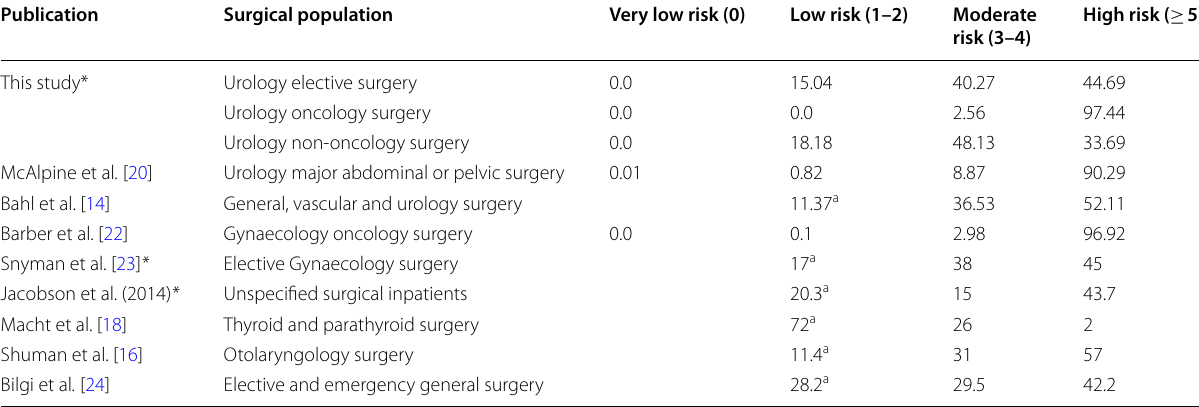
*South African data a These studies made use of risk-level terminology that differs from the ACCP guideline. Hence, low and very low risk categories are combined to align the categories with the equivalents from other